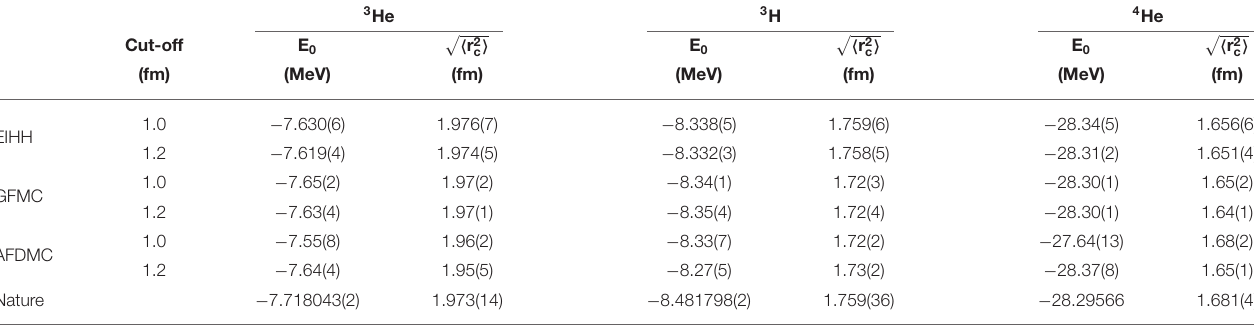
TABLE 3 | Ground-state energies and charge radii for the nuclear 3 He, 3 H, and 4 He systems at N2LO in the chiral expansion computed with the EIHH, GFMC, and AFDMC methods. 3 He 3 H 4 He